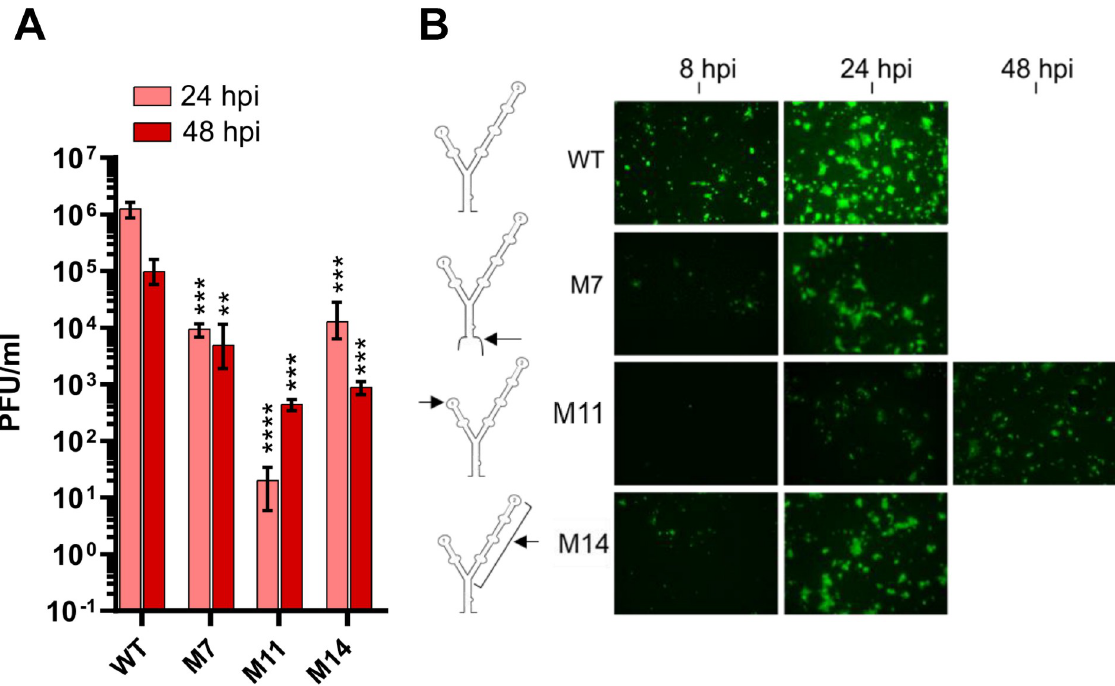
Fig 4. Infectivity of mammalian cells by 5 0 UTR mutants. ( A ) Quantification of plaque assays from PS cell supernatants infected with 5’UTR WT and mutant viruses 24 h post-infection (hpi). �� P < 0.001, ��� P < 0.001, ���� P < 0.0001 versus WT from 24 or 48 hpi determined in two biological replicates (n = 3 technical repeats). Data were analysed using a one-way Anova with Bonferroni’s correction. ( B ) Expression of NS5 in PS cells transfected with WT or mutant viruses assayed over the indicated timeframe. Schematic representation of the mutants within the Y-structure are shown